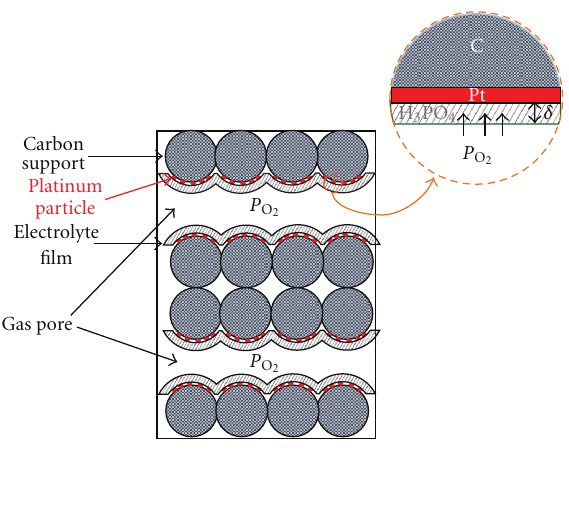
Figure 1: Schematic of catalyst layer using the thin film